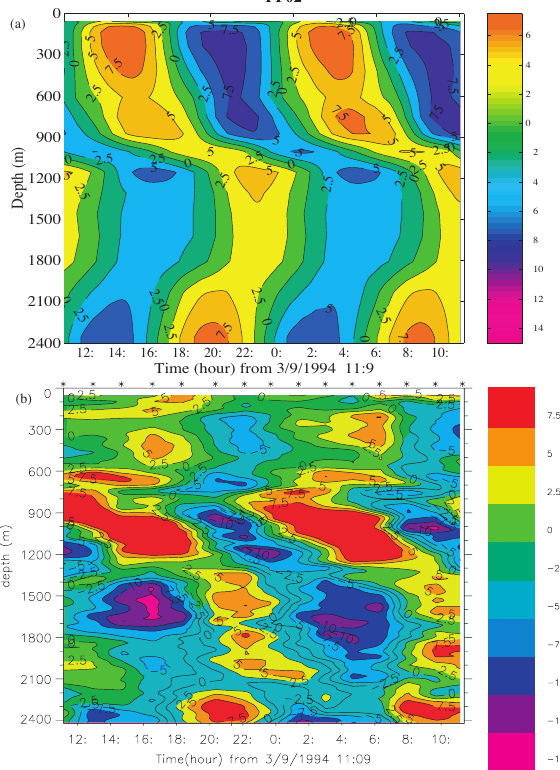
F IG . 12. – Time series of north-south baroclinic velocity at the PF02 location from the model (a) and from lowered ADCP measurements (b) during two semi-diurnal tidal cycles (25